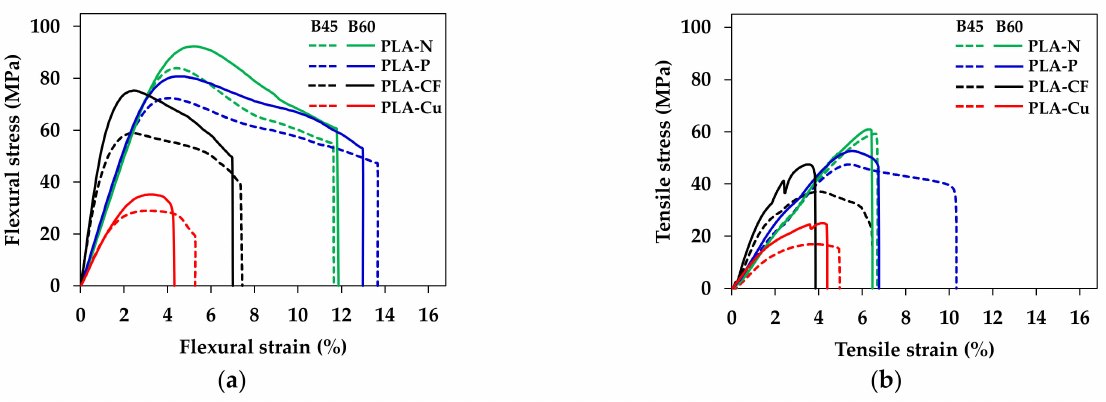
Figure 10. Typical stress–strain curves of 3D printed samples: ( a ) flexural test and ( b ) tensile